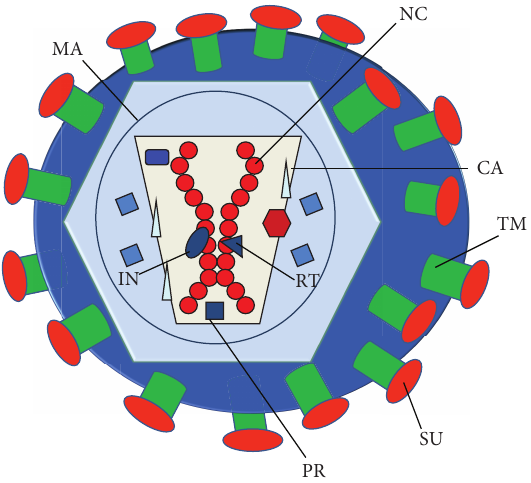
F 1: General structure of the retrovirion. e structure of the retrovirion is schematically shown in the �gure. e retrovirus contains a diploid RNA genome associated to the nucleocapsid protein (NC), forming the nucleocapsid. is nucleocapsid is associated to structural proteins involved in the retrotranscription (RT), integration (integrase, IN), and virion maturation (protease, PR). All these are enclosed by the capsid (CA) and matrix protein (MA). en, the virion envelope encloses the core and contains the envelope glycoprotein. In the case of retroviruses and lentiviruses, the envelope protein is made of the transmembrane (TM) and globular subunit